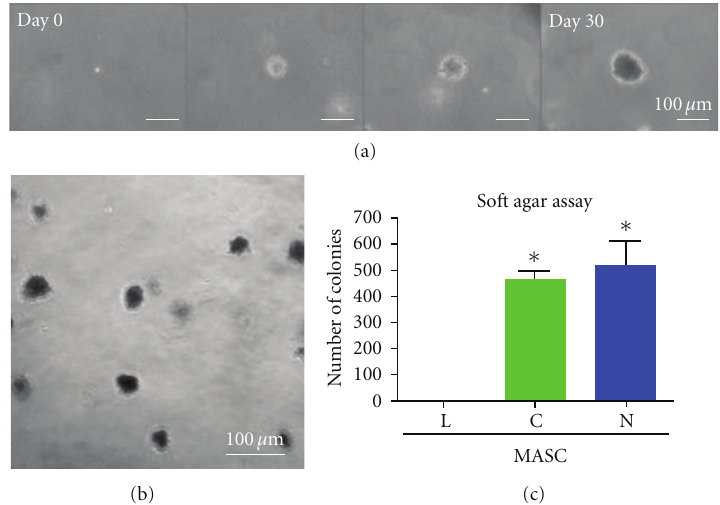
Figure 4: Anchorage-independent growth. Representative colonies of N-MASCs developed in soft agar at di ff erent time points (a). After 30 days, colonies were formed in N-MASCs (b) and C-MASCs culture, but not in L-MASCs culture, as represented in the histogram (c). Data are presented as mean ± standard deviation. ∗ P < . 05 versus